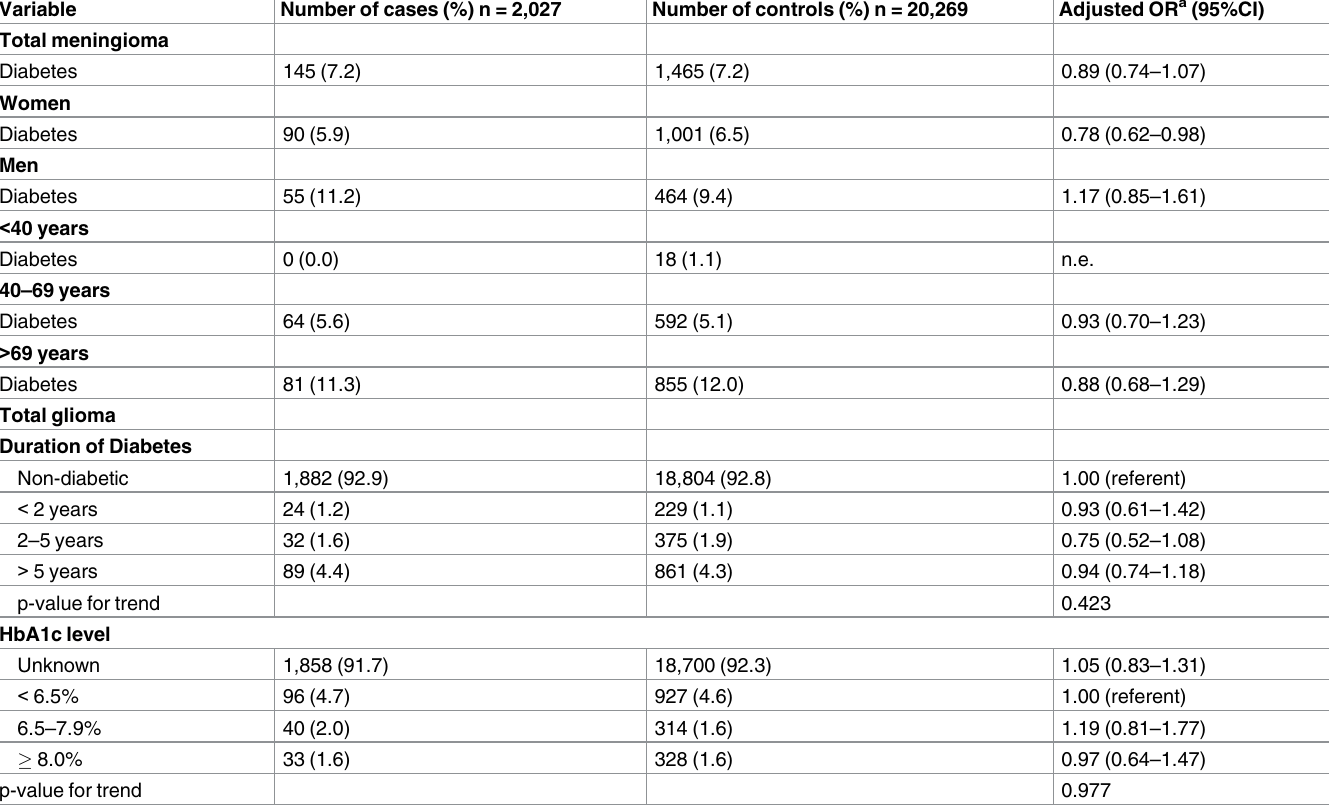
Table 2. Risk of meningioma in relation to diabetes status, duration of diabetes, and HbA1c level, overall and stratified by sex and